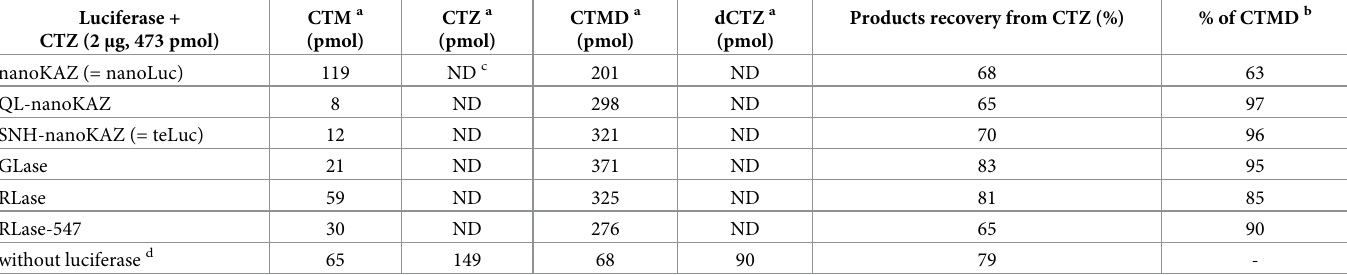
a Estimated with the peak area on HPLC chart using authentic CTM, CTZ, CTMD, and dCTZ as standards. b Calculated with the equation of CTMD/(CTM + CTMD). c Not detected. d Data from ref.